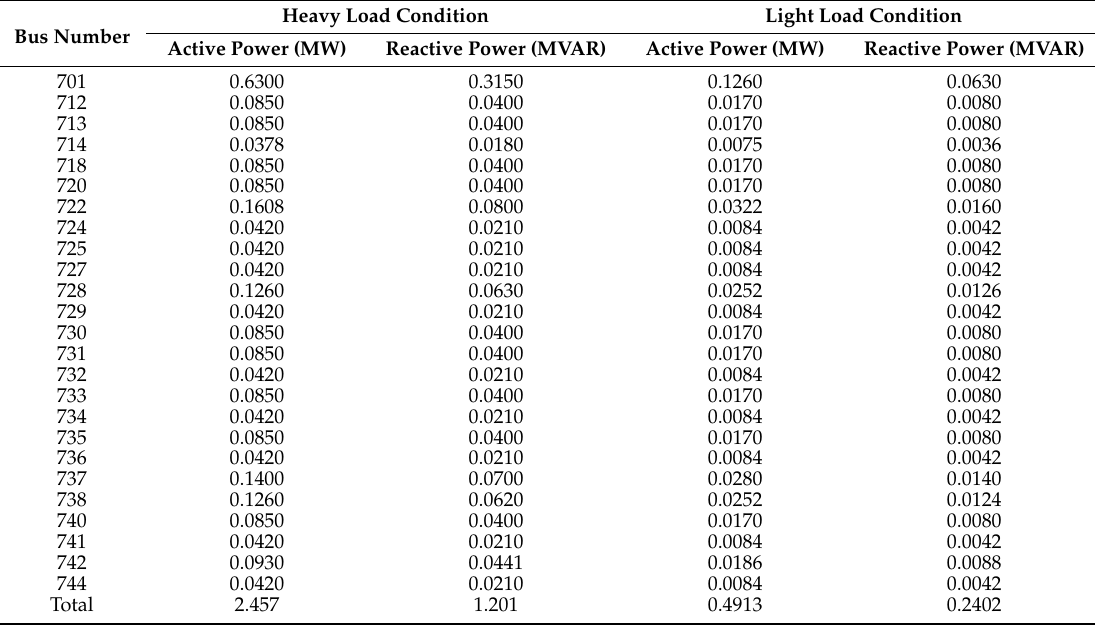
Table 1. Load demand of each bus.